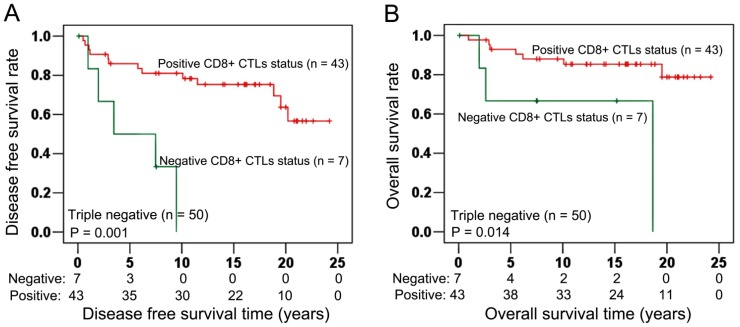
Association of CD8+ CTLs with survival in triple negative cancer.In ER, PR and HER-2 triple negative breast cancer, CD8+ CTLs infiltrate status had a strong and significant association with DFS (Log-rank test: P = 0.001; Fig. 5A). Moreover, positive CD8+ CTLs infiltrate status also had significant association with longer OS (Log-rank test: P = 0.014; Fig. 5B).